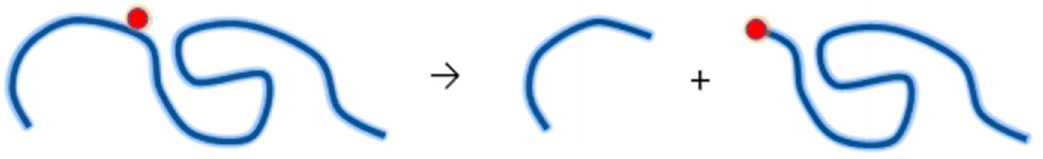
Figure 18. Degradation (chain scission) of a radical-bearing macromolecule.